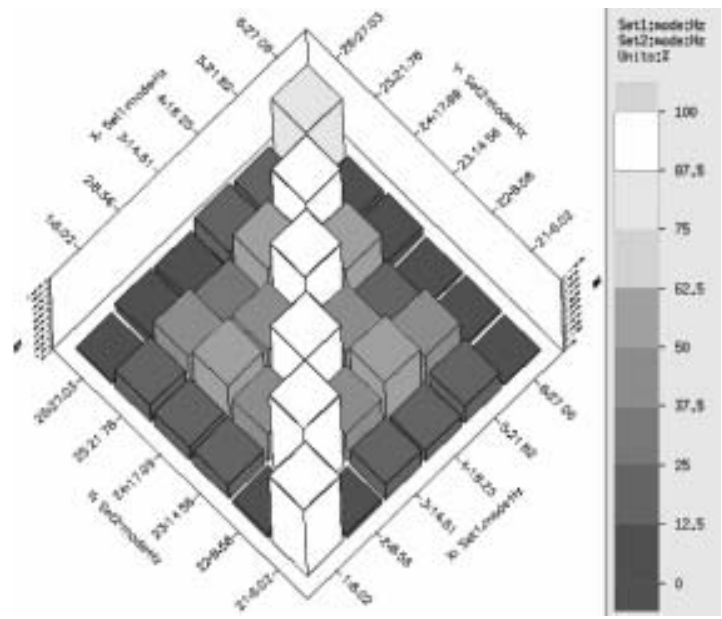
Fig. 2. MAC values assessing the mode shape correlation between FDPI and corresponding PolyMAX mode shapes.